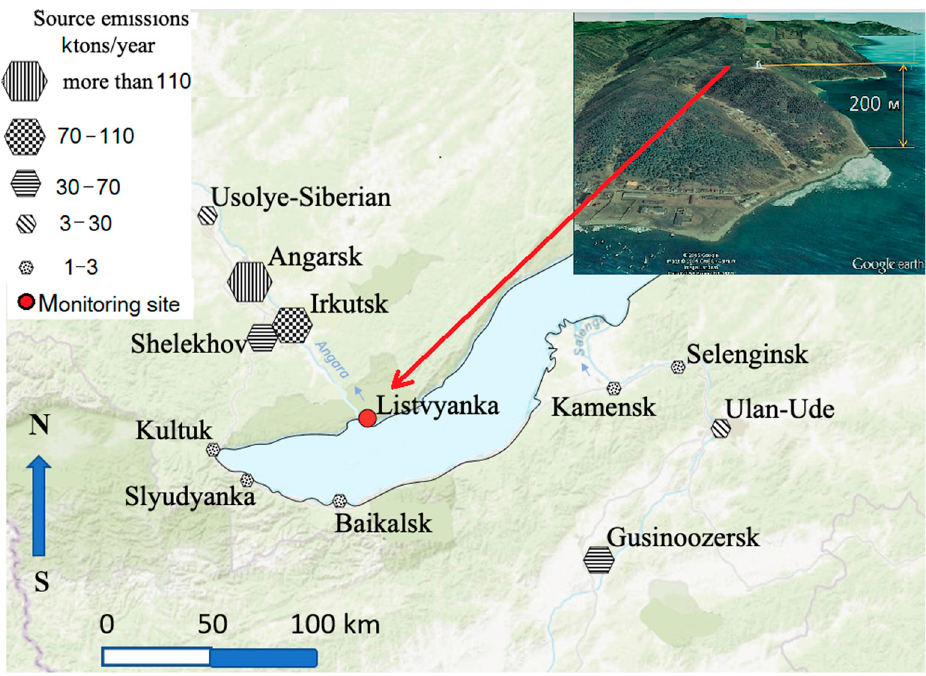
Figure 1. The layout of the monitoring station and the main cities as sources of air pollution. The inset shows a view of the location of the Listvyanka station atop the coastal hill.